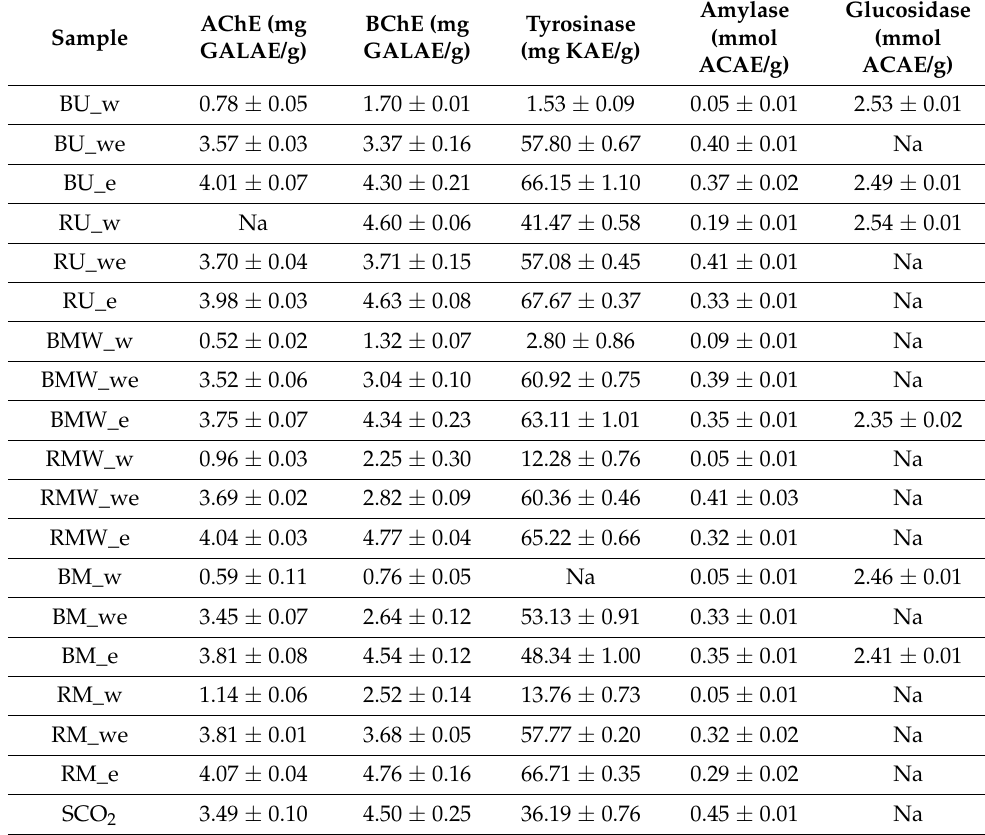
Values are reported as mean ± SD of three parallel measurements. GALAE: Galanthamine equivalents: KAE: Kojic acid equivalents; ACAE: Acarbose equivalent. Na: not